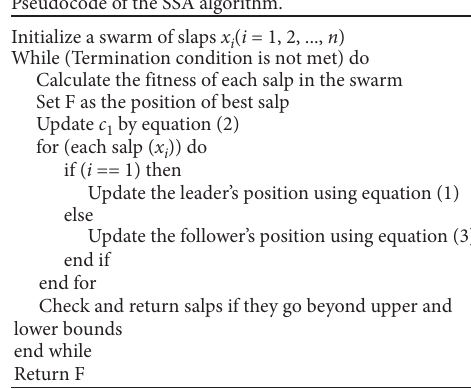
Figure 2: Salp Swarm Algorithm